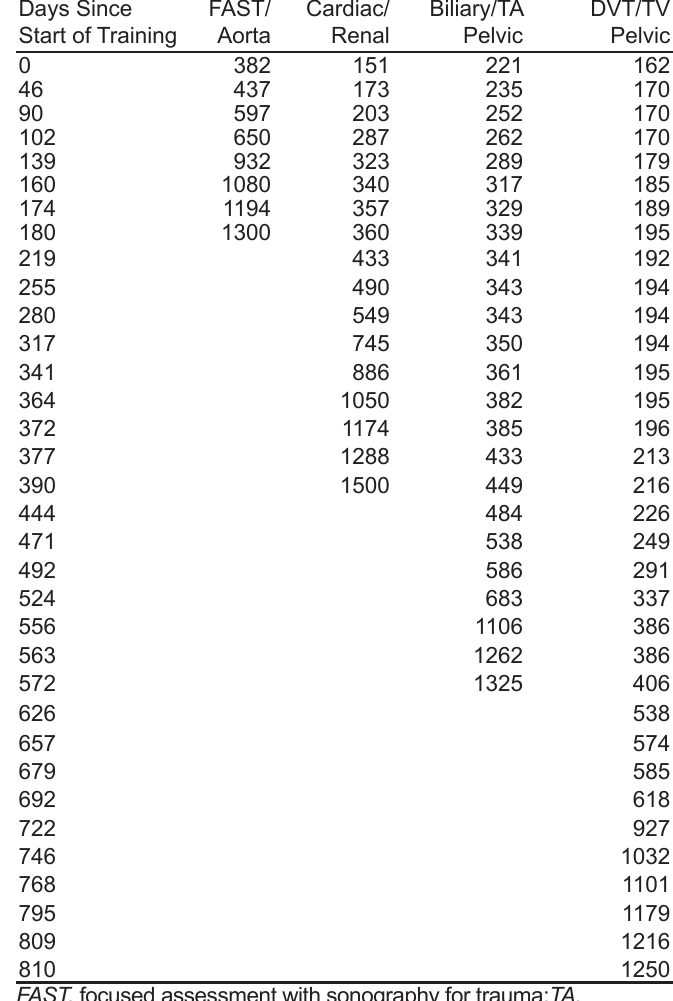
Table 3. Total numbers of ultrasound exams performed since initiation of the training